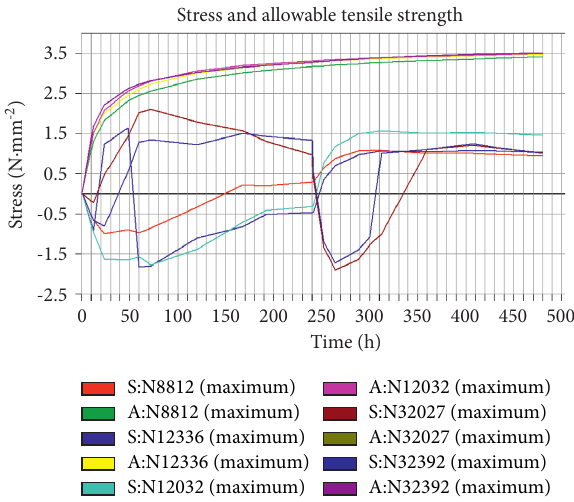
Figure 15: Time-history curve of main tensile stress at the second layer of cap.